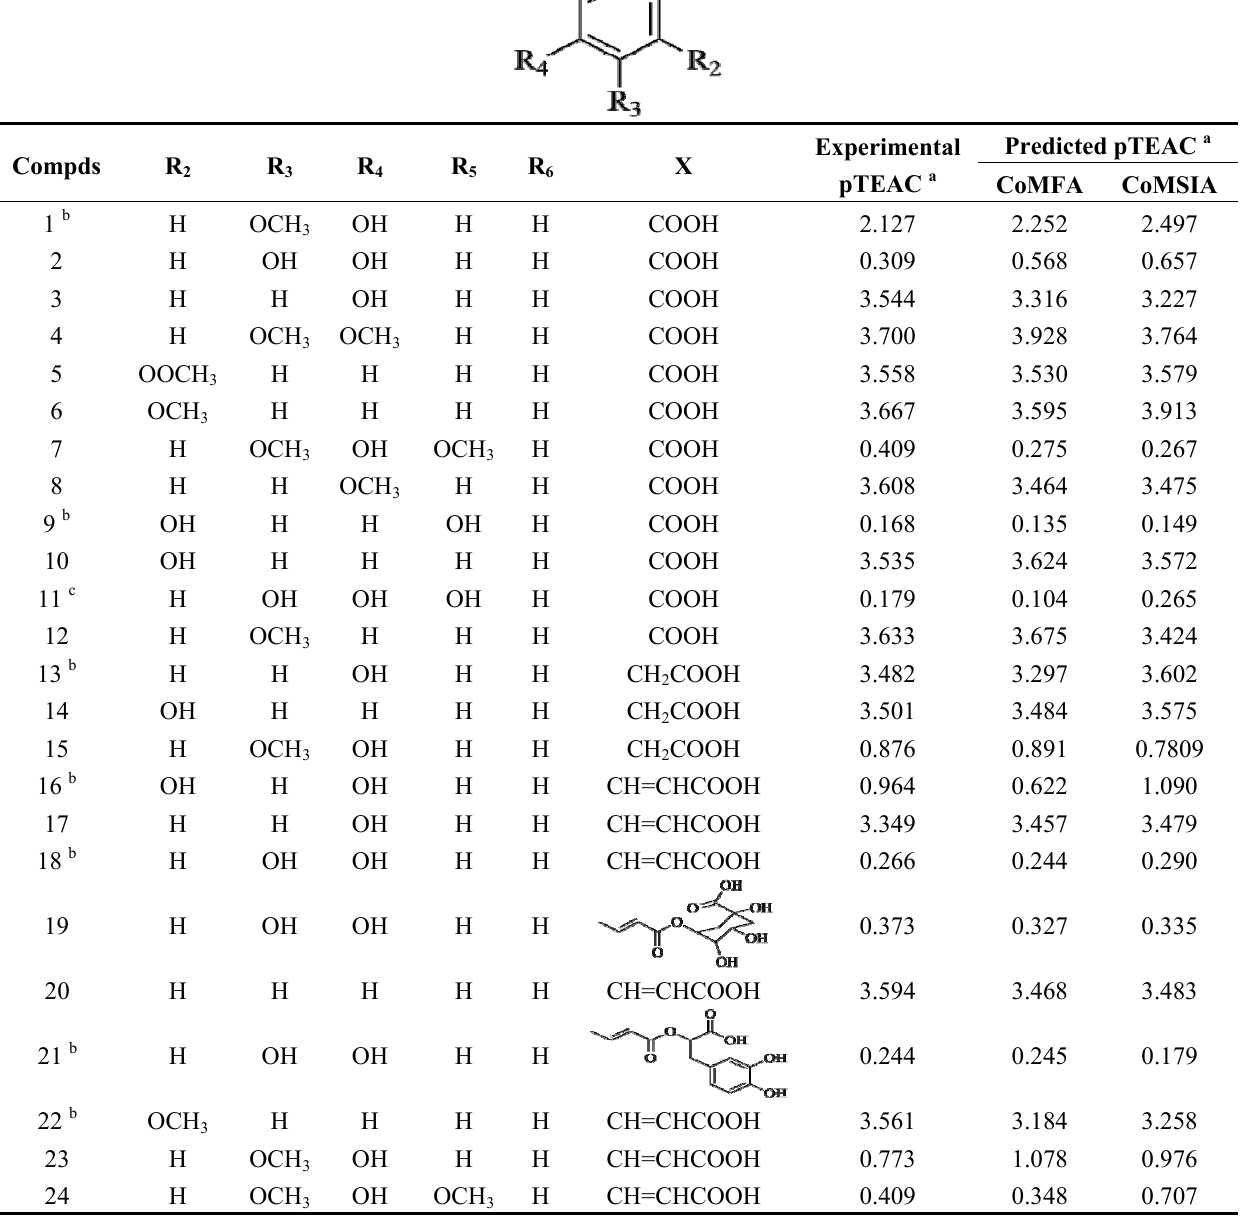
Table 2. Chemical structure and experimental activities of phenolic acid